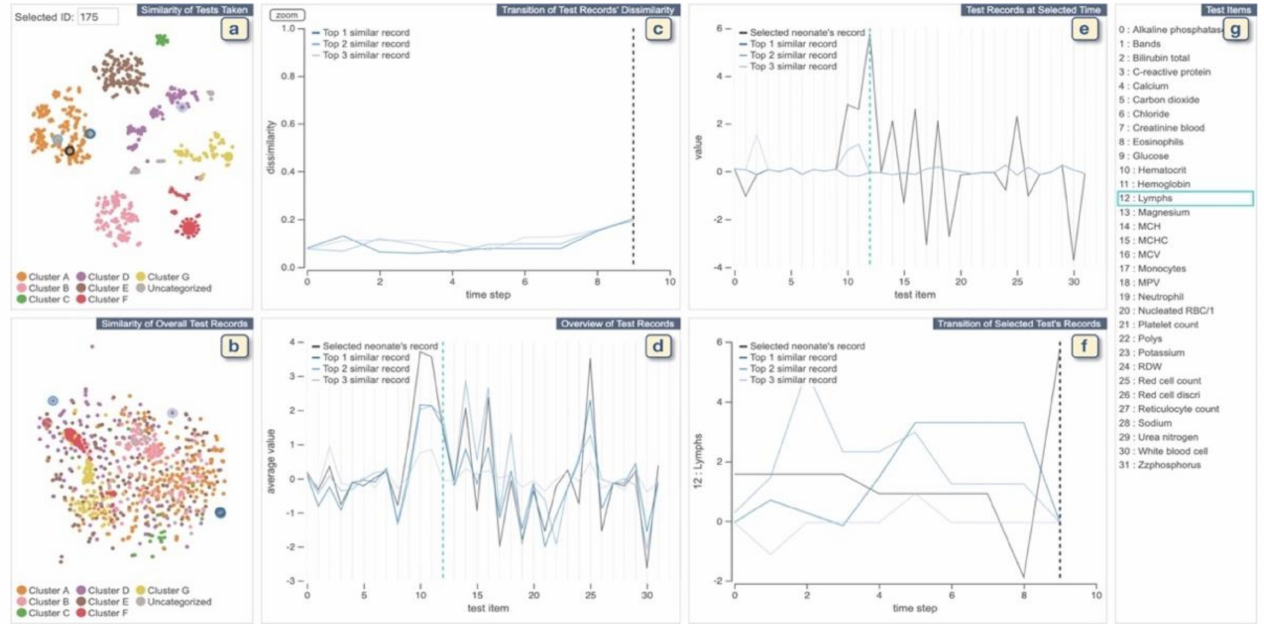
Figure 5. The screenshot of the VA system developed by Guo et al. [41]. ( a , b ) display each neonate’s similarities of tests taken and the records of test values, respectively. ( c ) shows changes of dissimilarities of test records over time between the neonate chosen from ( a , b ) and top-3 similar neonates. ( d ) displays a statistical overview of the chosen neonate and top-3 similar neonates. ( e ) provides all the test results at the selected time in ( c ) or ( f ). ( f ) displays the temporal changes of values of the chosen test in ( d ) or ( e ). ( g ) lists all medical test names. Source: Reprinted with permission from ref. [41], Copyright (2020), with permission from